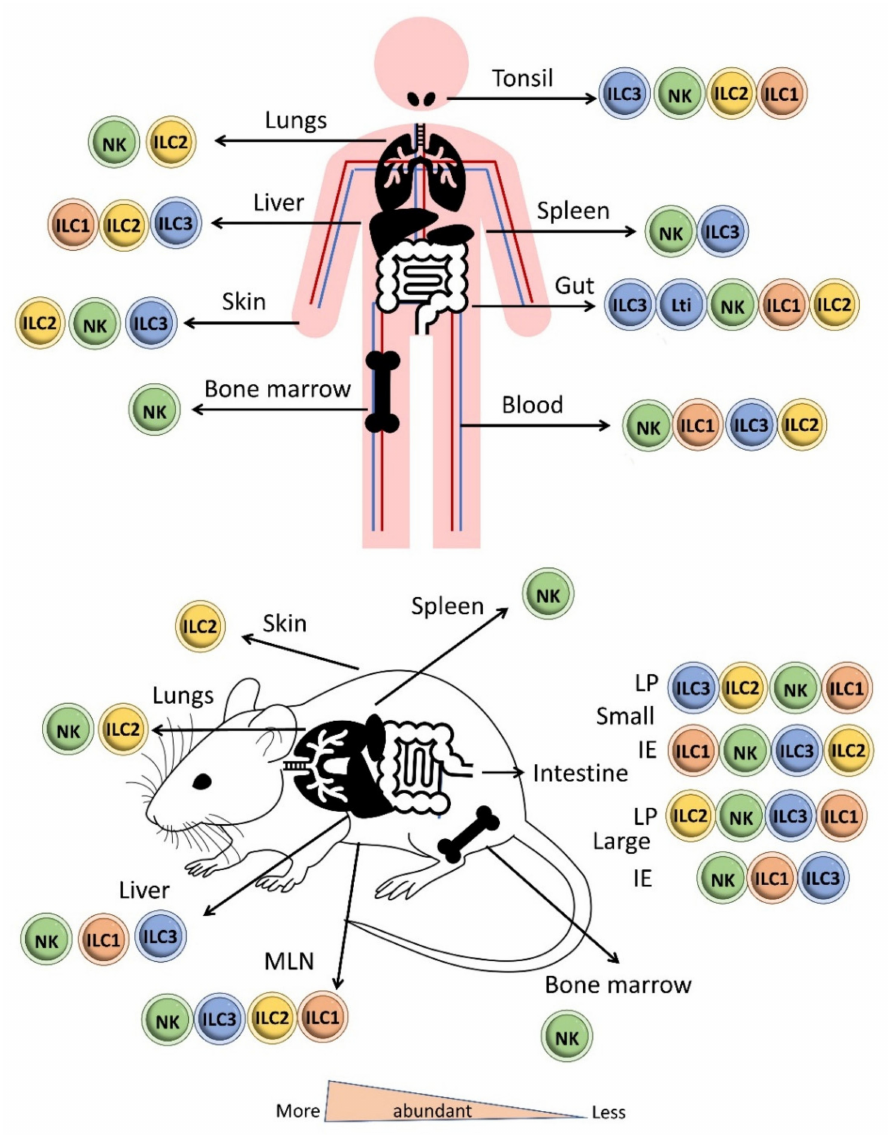
Figure 4. Distribution of ILCs in the body in human and mouse. NKs are circulating cells that are mainly found in the systemic circulation, cord blood, bone marrow, spleen, lungs and throughout the human gut. ILC1s are tissue-resident cells that mainly reside in intestinal tissues and tonsils but are also located in the liver, salivary glands, uterus and thymus. ILC2s are mainly found in adipose tissue, mesenteric lymph nodes, lungs, skin and tonsils. ILC3s are mainly present in mucosal tissue and at low levels in the spleen and liver. LTis cells are predominantly located in intestinal and lymphoid tissues, whereas NCR + ILC3s and NCR − ILC3s are more prominent in the skin and intestinal lamina propria. (LP: Lamina propria; IE: